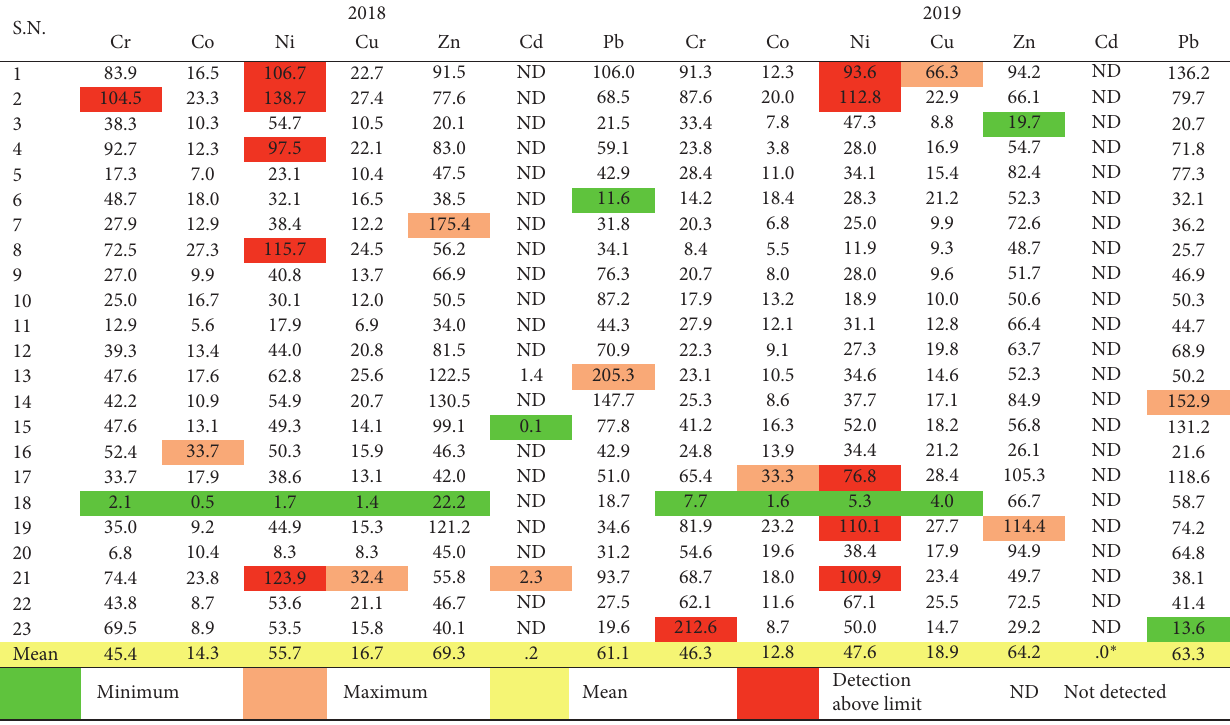
Table 3: Heavy metal content values of all soil samples (mg/kg).